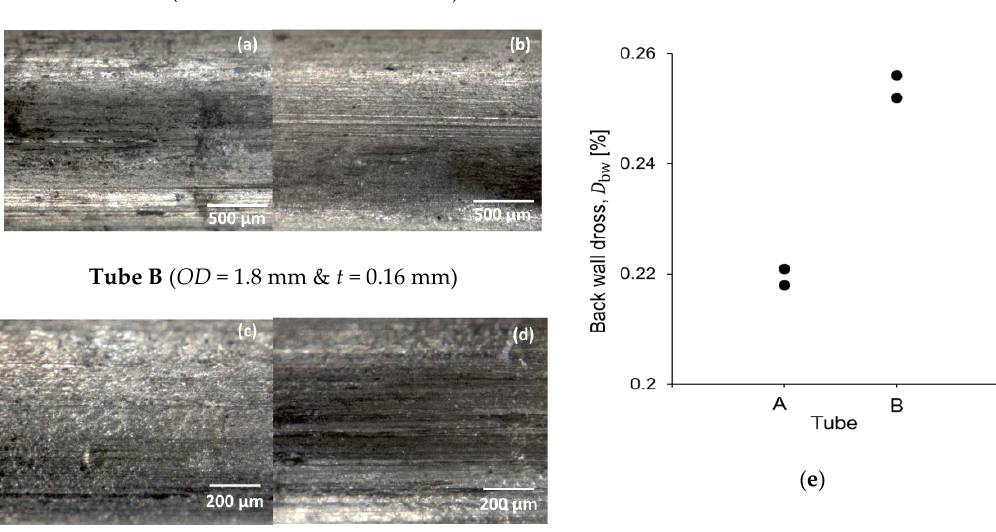
Figure 9. Comparison of treatment: without ( a , c ) and with ( b , d ) gas blowing through the tube. ( e ) Back-wall dross response under the condition of blowing gas inside the tube.